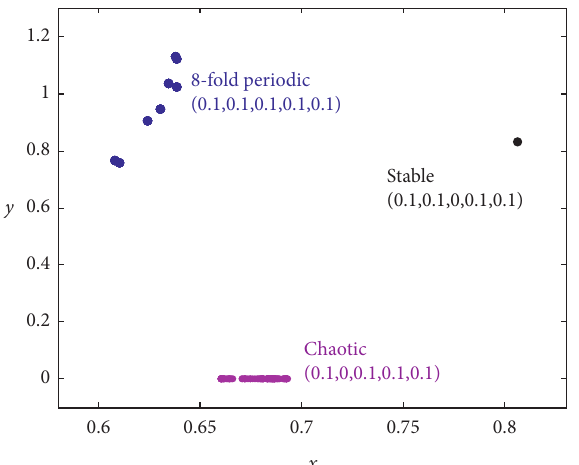
Figure 31: When a � 1, b � 1.14, c � 2.93, d � 1.3, e � 0.21, f � 0.1, g � 0.35, h � 2, α � 0.05, β � 2, and c � 0.15, multistability results of the system where the blue points denote 8-fold periodic states corresponding to initial value (0.1, 0.1, 0 .1, 0.1, 0.1), the black point denotes a stable state of equilibrium point corresponding to initial value (0.1, 0.1, 0, 0.1, 0.1), and the rose points denote chaotic state corresponding to initial value (0.1, 0, 0.1, 0.1,